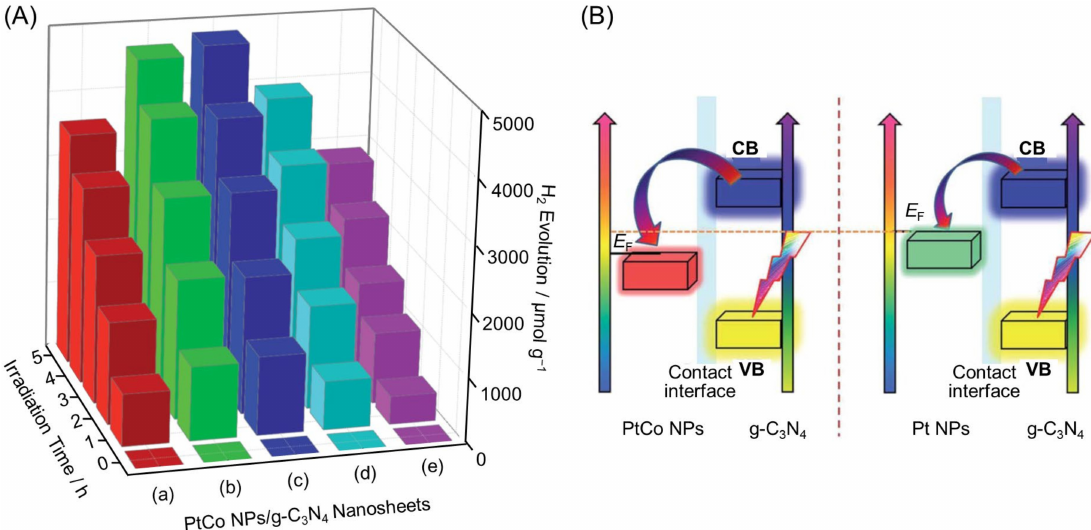
Figure 21. ( A ) Photocatalytic H 2 evolution from aqueous solution containing 10 vol% of tri- ethanolamine (sacrificial reagent) under Vis-light irradiation ( ≥ 400 nm) over Pt 1 − x Co x NPs/g-C 3 N 4 nanosheets with different Pt/Co percentages at the same loading of 1.0 wt%; x = (a) 0, (b) 0.25, (c) 0.5, (d) 0.75, and (e) 0.86. ( B ) Schematic illustration of photoexcited electron injection from CB of g-C 3 N 4 to the PtCo NPs and Pt NPs. Reproduced with permission from reference [220]. Copyright 2015 The Royal Society of Chemistry.